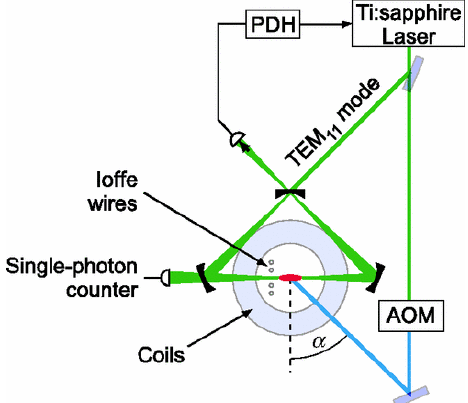
Figure 13. Geometry of the experiment: A BEC is created in a Ioffe–Pritchard trap and then placed in the waist of a TEM 11 mode of an optical ring cavity (green). A pump beam is irradiated from the side under the angle α = 37 ◦ . A single-photon counter records the photons transmitted through one of the cavity mirrors. Reprinted with permission from ref. [56]. Copyright 2013 American Physical